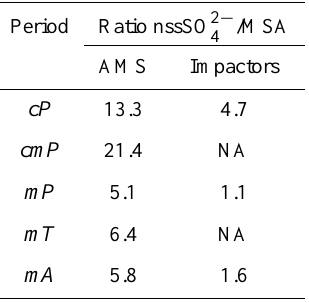
Table 4. Ratios of nss-Sulphate to MSA for the AMS and impactor measurements.